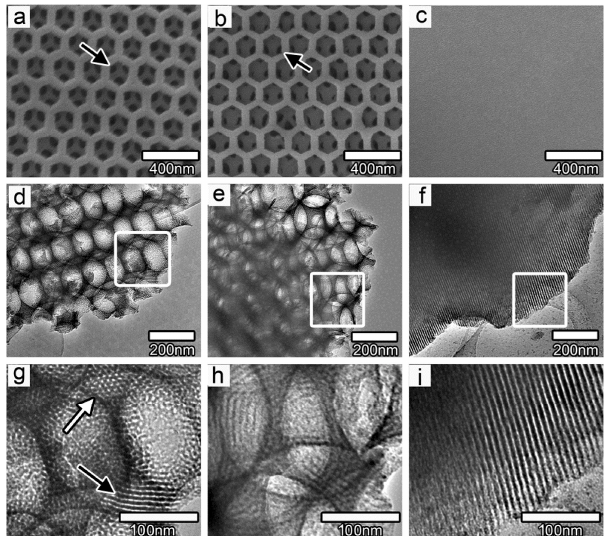
Figure 9. TEM and SEM images of ( a , d , g ) macro-mesoporous TiO 2 films and ( b , e , h ) with graphene and ( c , f , i ) pure mesoporous TiO 2 film. ( a , b ) The black arrows indicate the interconnected channels between macropores in the film, while ( g ) the white and black arrows point the mesopores contained in the macropore walls. Reprinted with permission from [41]. Copyright 2018, American Chemical Society.